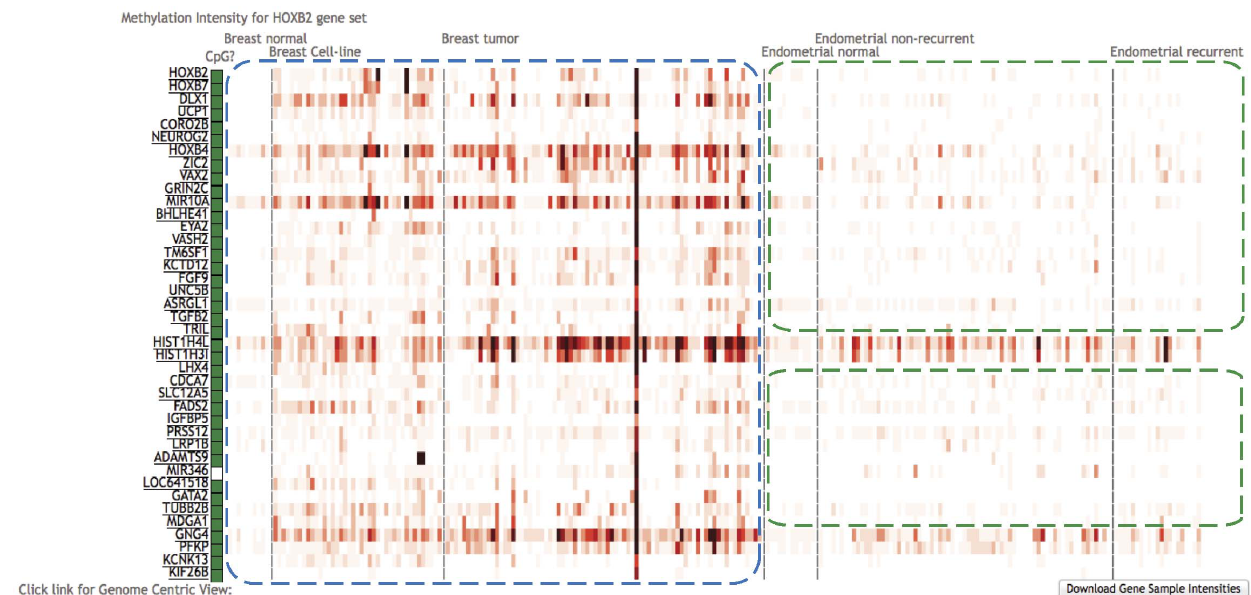
Figure 4. Discovery of methylation correlated genes. Gene set with similar methylation profiles of HOXB2 were found by choosing the ‘‘Correlated gene’’ gene sets in the gene centric view. Most of the genes are hypermethylated in breast tumors (blue dash box), and with no significant difference in endometrial samples (green dash box).